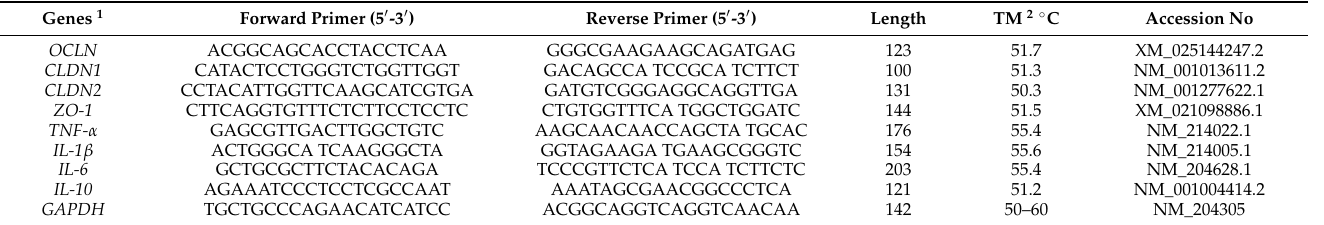
Table 2. Primer sequences of target